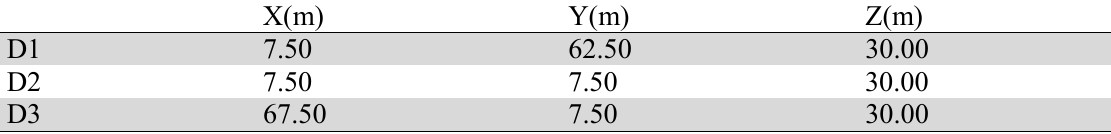
Coordinate of demand locations